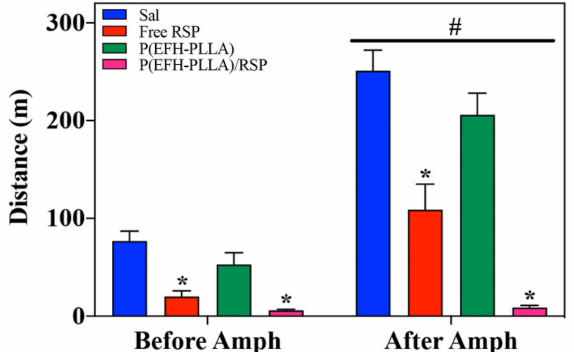
Figure 7. Distance analysis using ANOVA (analysis of variance) of open field test with hollow and RSP-loaded NP treatment 0–30 min prior to amphetamine administration and 30–60 min post amphetamine uptake. Asterisks (*) denote statistical significance versus saline and the hashtag (#) signifies the e ff ect of amphetamine administration.